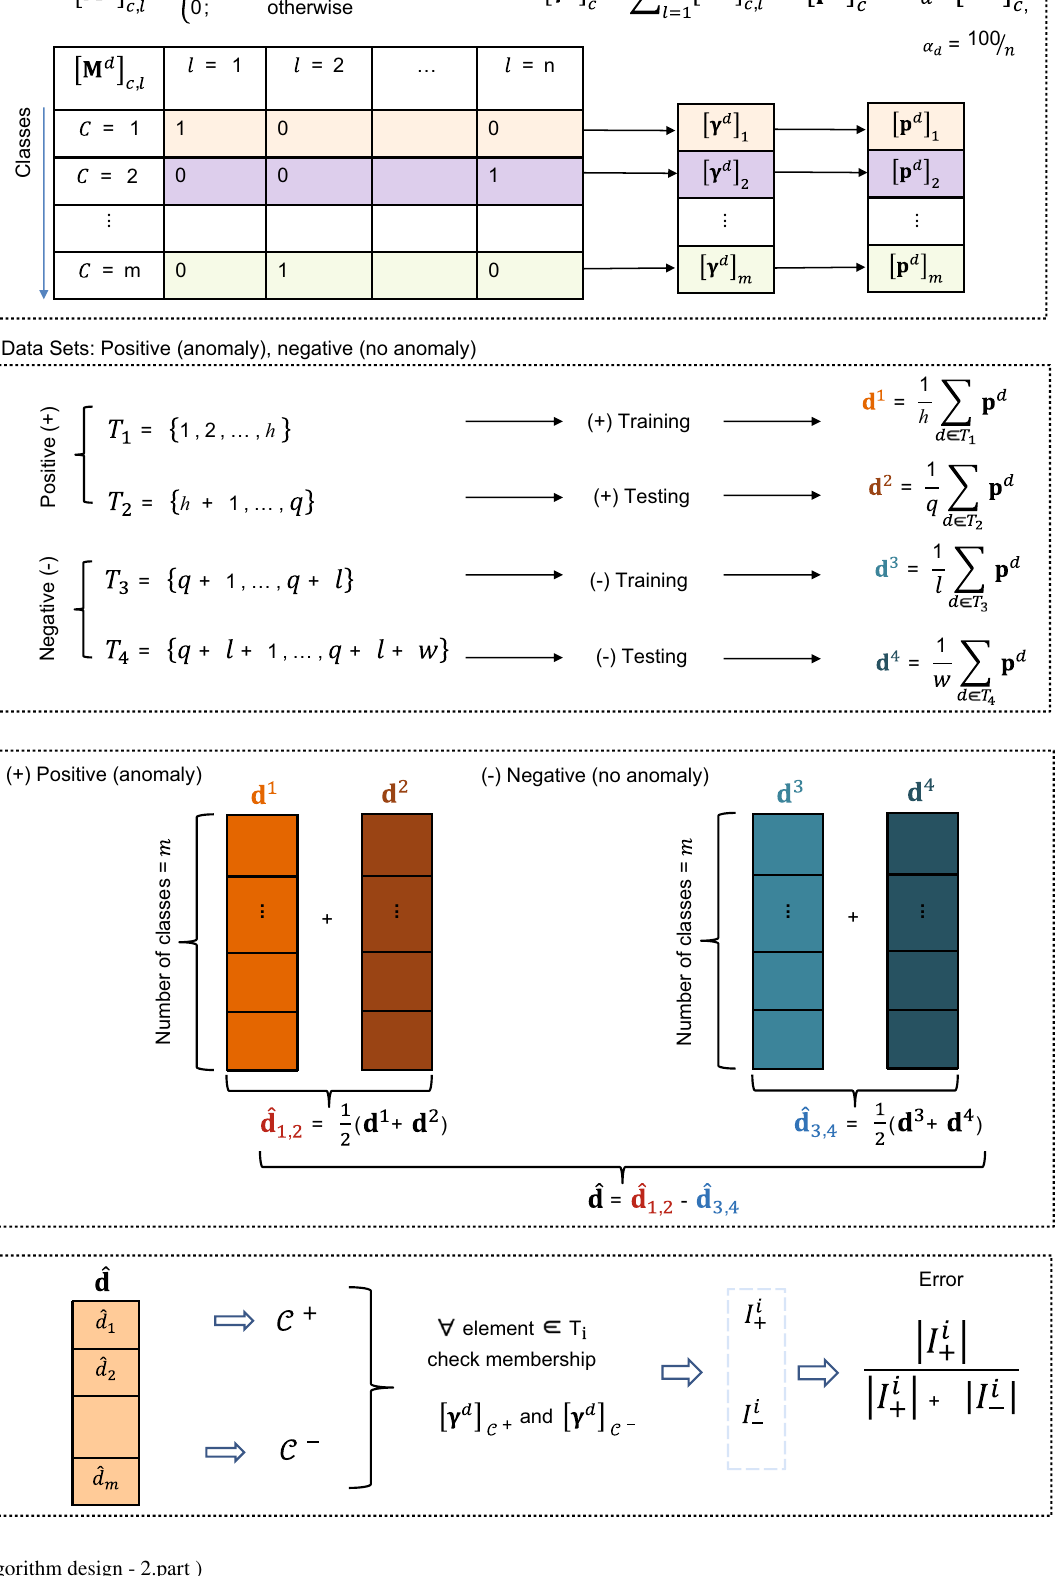
Fig. 3 (Algorithm design - 2.part